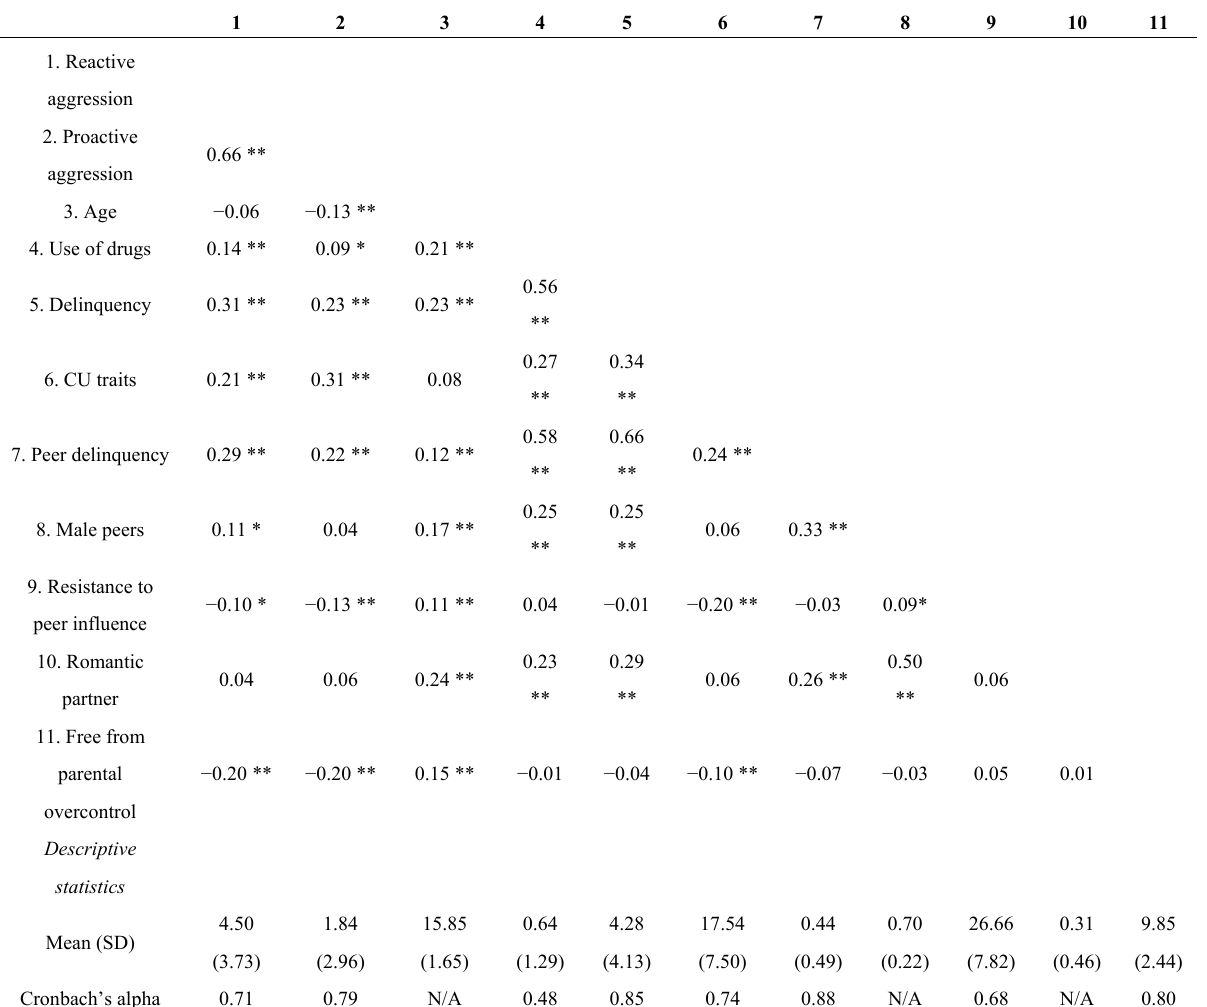
Table 2. Correlations among the main study